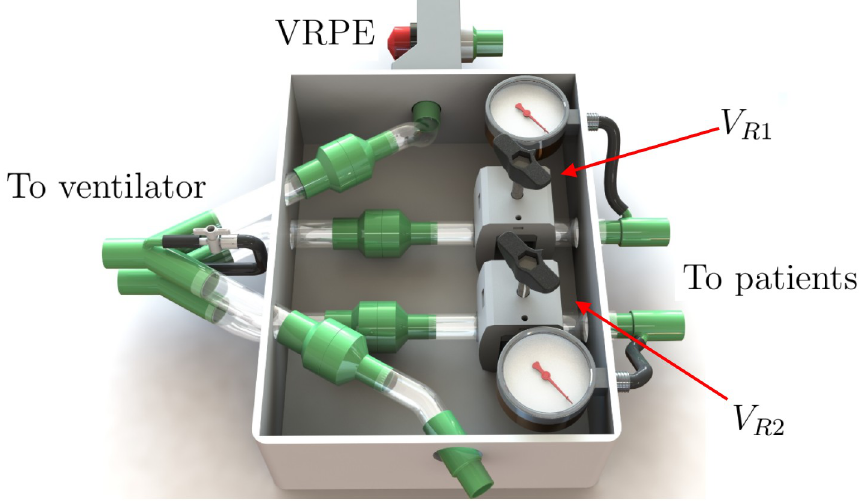
Fig 12. Render of the different components of the ACRA. V VRPE adjustable threshold valve (PEEP valve) (ad hoc design). Also shown, analogical manometers the device uses and ad hoc one-way valves (3D printed with medical-grade resin and incorporated silicone